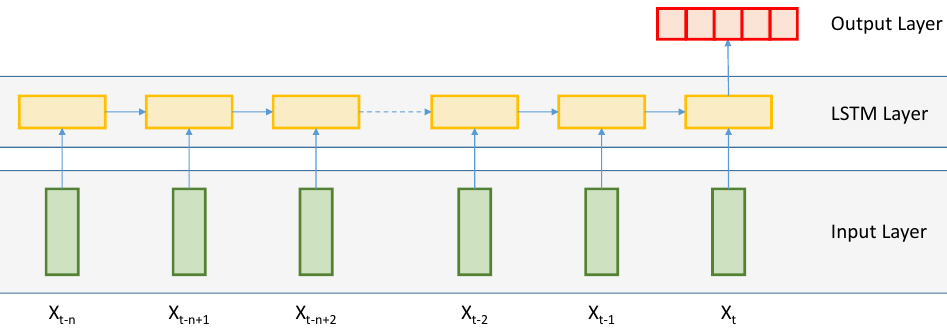
Figure 3. The architecture of the proposed LSTM model.